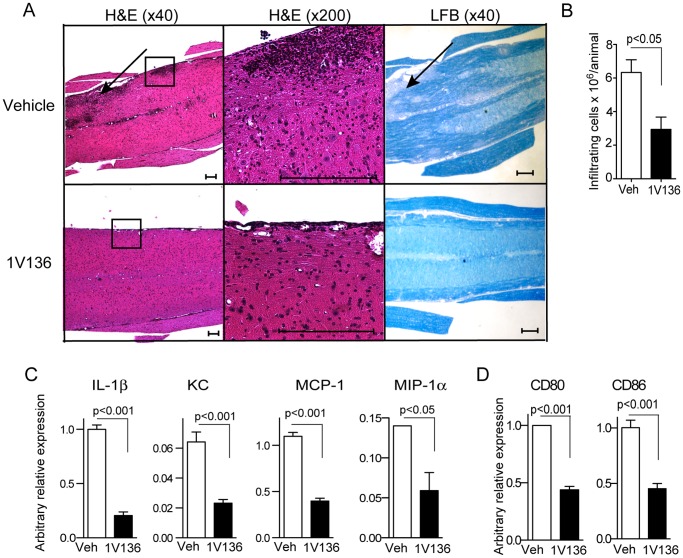
TLR7 ligand treatment reduced spinal cellular infiltration, and spinal chemokines and cytokines of EAE mice.(A) Representative sagittal sections of lumbar spinal cords from vehicle-treated or 1V136-treated EAE mice. H&E stained sections are shown in the left panels (×40 original magnification) and the insets are shown at higher magnification (middle panels, ×200 original magnification). Areas of demyelination are indicated by the arrows in the LFB stained sections (right panels). Scale bars:100 µm. (B) The total number of infiltrating cells isolated from pooled spinal cords from vehicle-treated (Veh) or 1V136-treated (1V136) EAE mice (n = 5/group). The data shown are averages of three independent experiments ± SEM. p<0.05 by Student t test. (C) 1V136 treatment reduced chemokine expression in the spinal cords in the EAE mice. Chemokine expression levels in the spinals cords were reduced in 1V136-treated EAE mice. RNA was extracted from pooled spinal cord samples collected from 1V136-treated (n = 4) or vehicle-treated (n = 4) mice. mRNA levels of IL-1β, KC, MCP-1 or MIP-1α were analyzed by qPCR methods. The data were normalized to 18S ribosomal RNA gene and are presented as arbitrary units. p<0.05 by Student t test. Data shown are representative of two independent experiments that exhibited similar results. (D) The levels of CD80 and CD86 mRNA transcripts were also reduced in the spinal cords of 1V136 treated mice. Data are presented as arbitrary units as normalized to GAPDH. p<0.05 by Student t test.